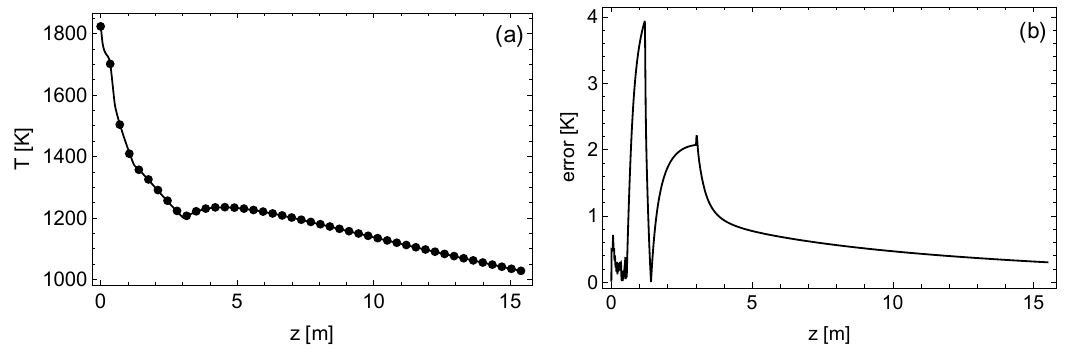
Figure 4. ( a ) Reconstructed (solid line) and measured (dots) distribution of temperature and ( b ) the absolute error of this reconstruction obtained in control point “2” (thermocouple “2”) for the measurements read at every 0.01m and burdened by 5% error (one step optimization).